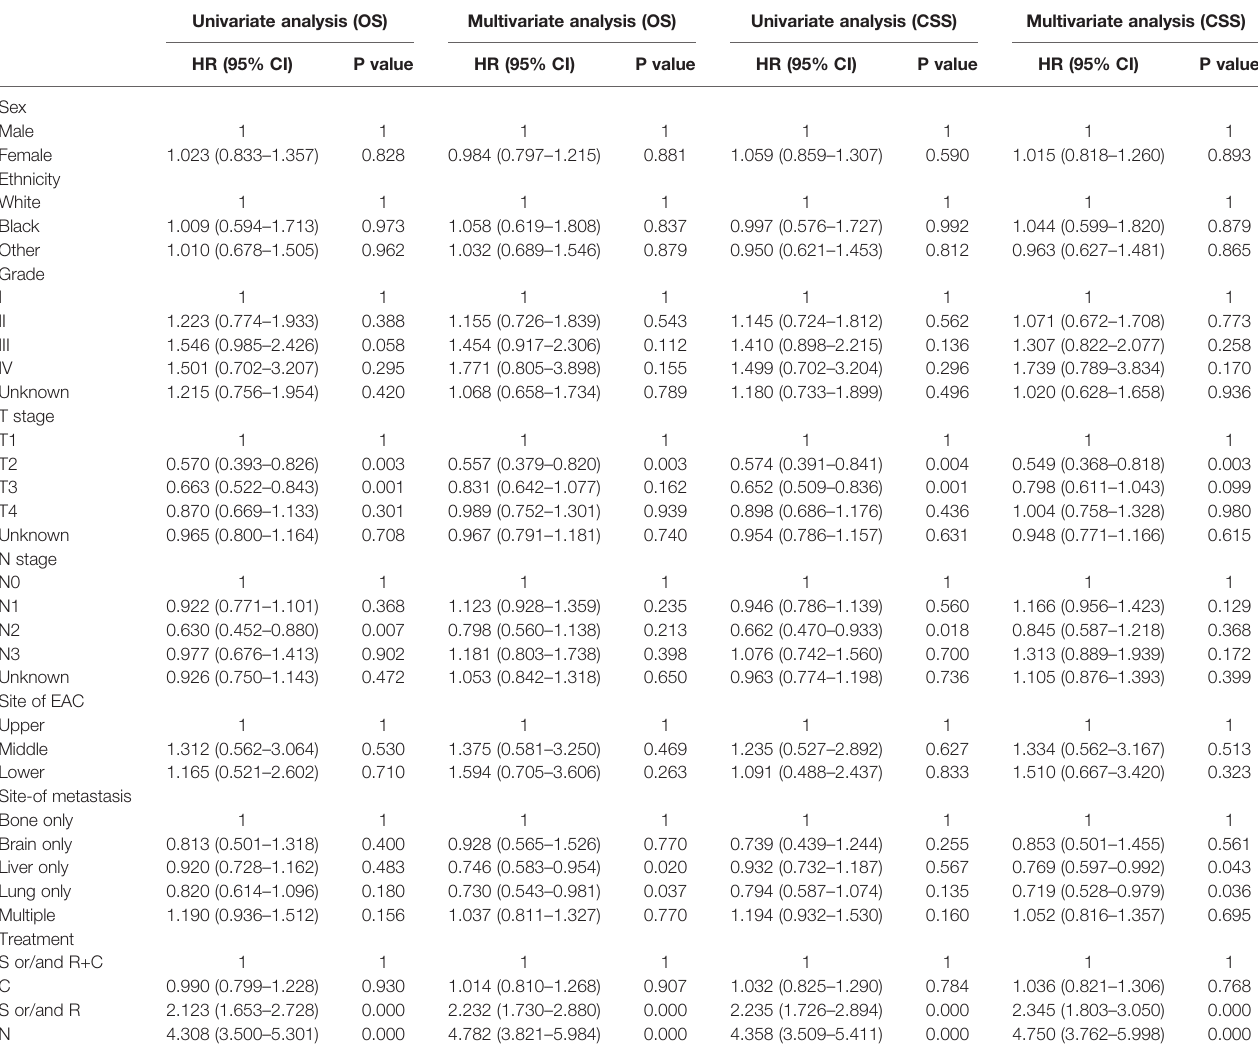
TABLE 2 | Results of Univariate and Multivariate analysis using the COX proportional hazards model of the study population. Univariate analysis (OS) Multivariate analysis (OS) Univariate analysis (CSS) Multivariate analysis